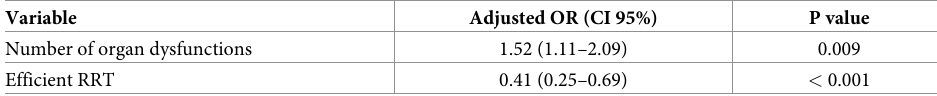
Multiple logistic regression with variables adjusted for type of hospital, age, sex, smoking, number of comorbidities, lower tercile of platelets and higher creatinine at admission, use of vasoactive drugs, mechanical ventilation, and serum measurements (potassium < 5 mEq/ml, bicarbonate > 22 mEq/ml, urea > 150 mg/dl, and upper tercile of creatinine). OR: Odds ratio; RRT: Kidney replacement